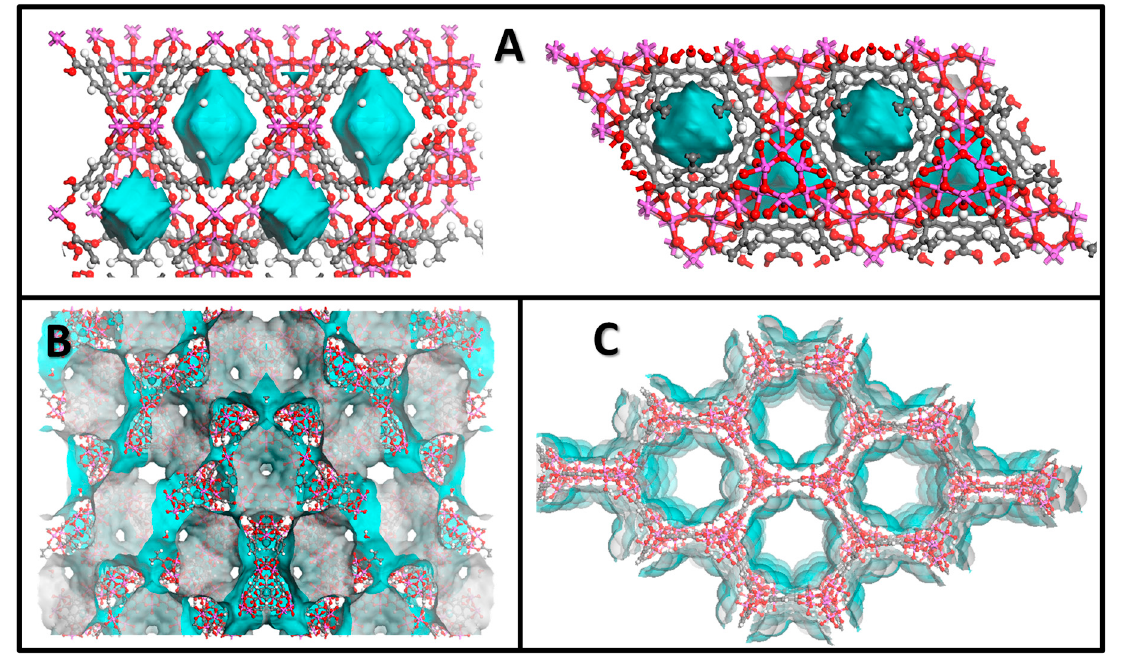
Figure 4. Representation of accessible water surface (blue) for ( A ) MIL-96(Al), ( B ) MIL-100(Al) and ( C ) MIL-110(Al) adsorbents.